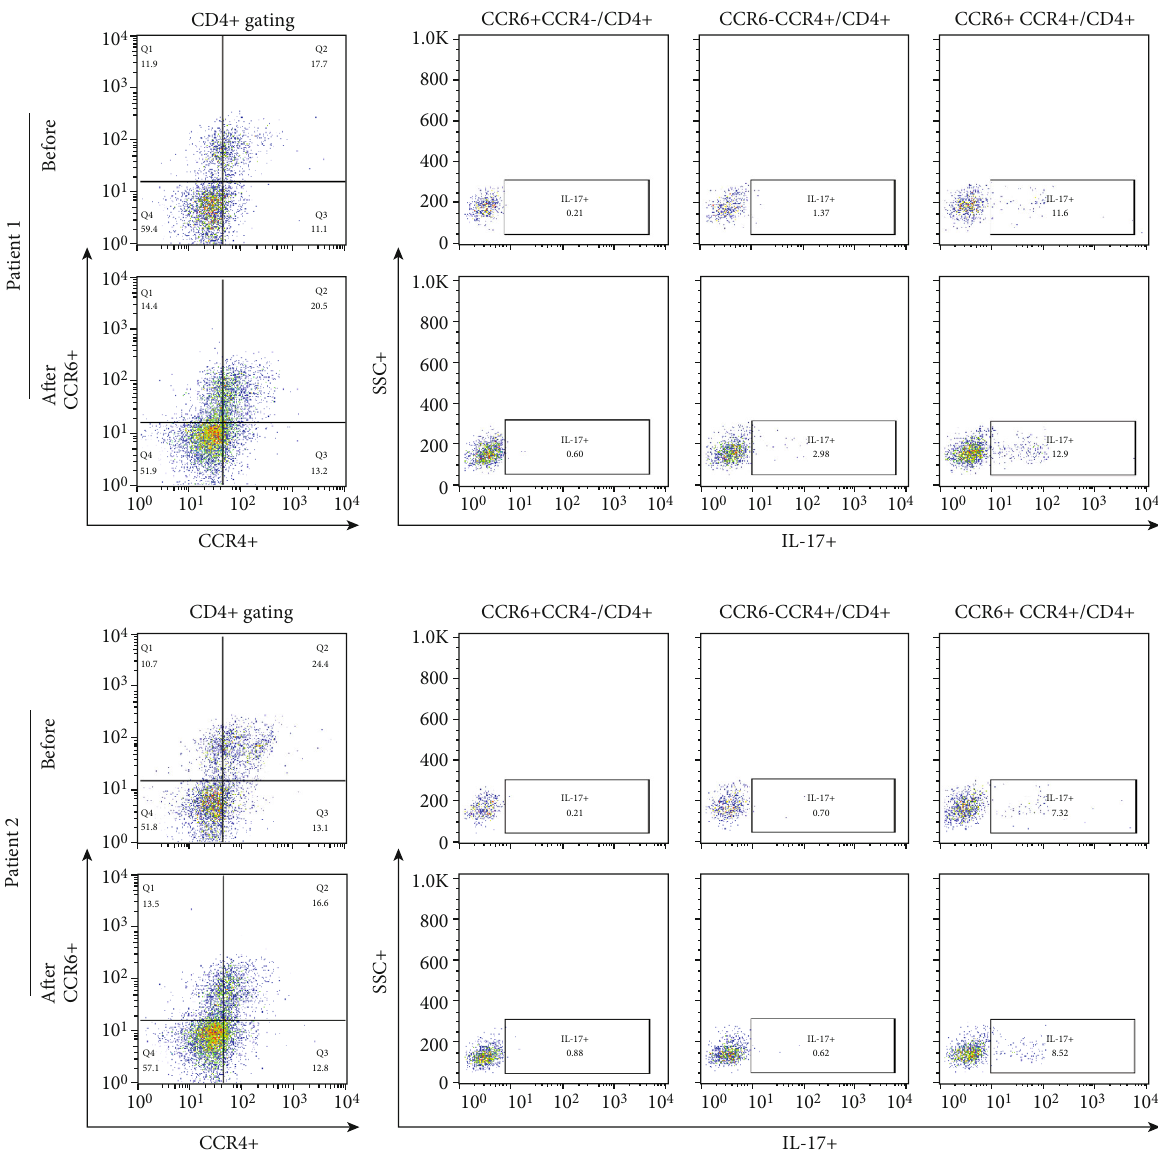
Figure 5: Comparison of CCR6+ CCR4-, CCR6-CCR4+, and CCR6+CCR4+ subpopulations of CD4+ T lymphocytes before and after MSC treatment. PBMCs were stained with anti-CD4 PE-Cy7-conjugated, anti-CCR4 PE-conjugated, anti-CCR6 APC-conjugated, and anti-IL-17 FITC-conjugated antibodies. CD4+ T cells were gated for further analysis. The proportions (%) of CCR6-CCR4+/CD4+ T cells, CCR6+CCR4-/CD4+ T cells, and CCR6+CCR4+/CD4+ T cells in each patient were determined. After surface staining with anti-CD4, anti-CCR4, and anti-CCR6 mAbs, analysis of IL-17 expression in CD4+ T cell subsets by intracellular fl ow cytometry was performed. The proportion (%) of IL-17+/CCR6+ CCR4+CD4+ T cells in each patient was determined. “ Before ” indicates the results at the start of MSC treatment, and “ After ” indicates the results at 3 months after the fi nal MSC infusion. MSCs: mesenchymal stem cells; PBMCs: peripheral blood mononuclear